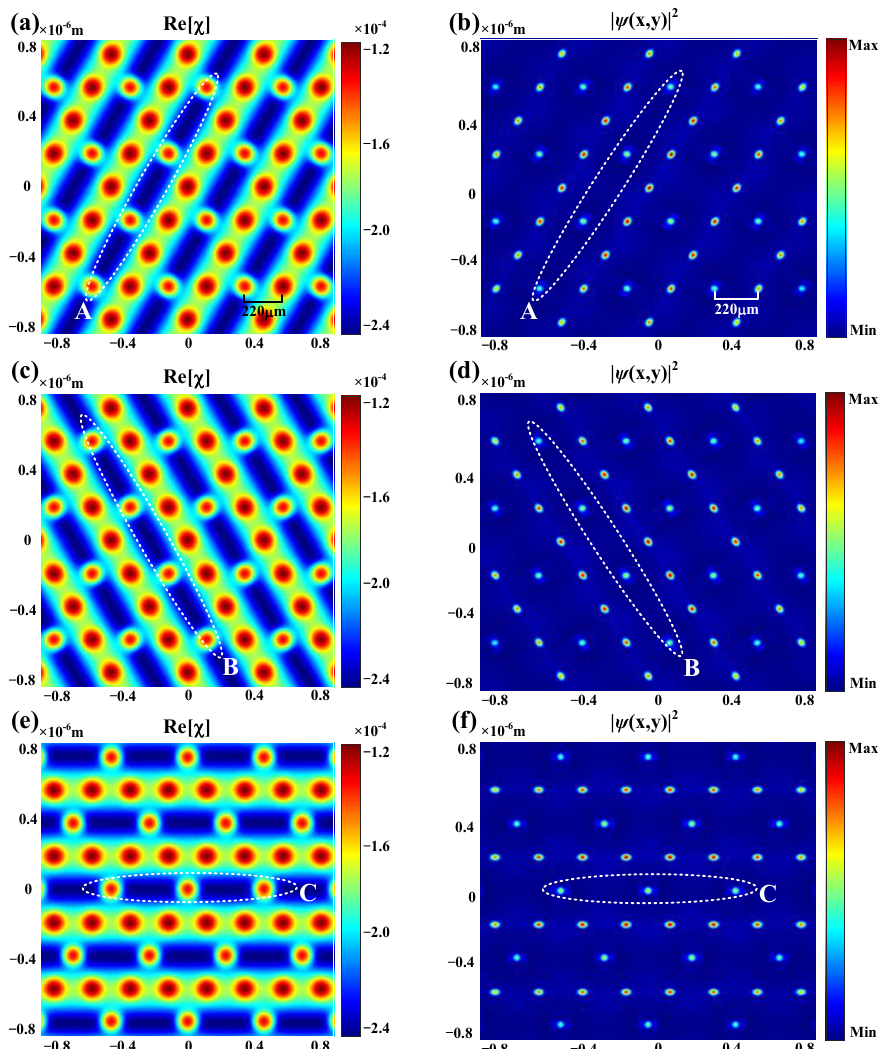
Figure 4 shows the intensity of the region marked by a dashed line. This white dashed line and the intensity curve come from the software of the CCD camera itself.